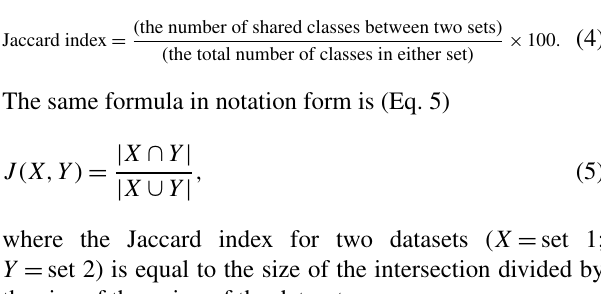
where the Jaccard similarity index is calculated as (Eqs.